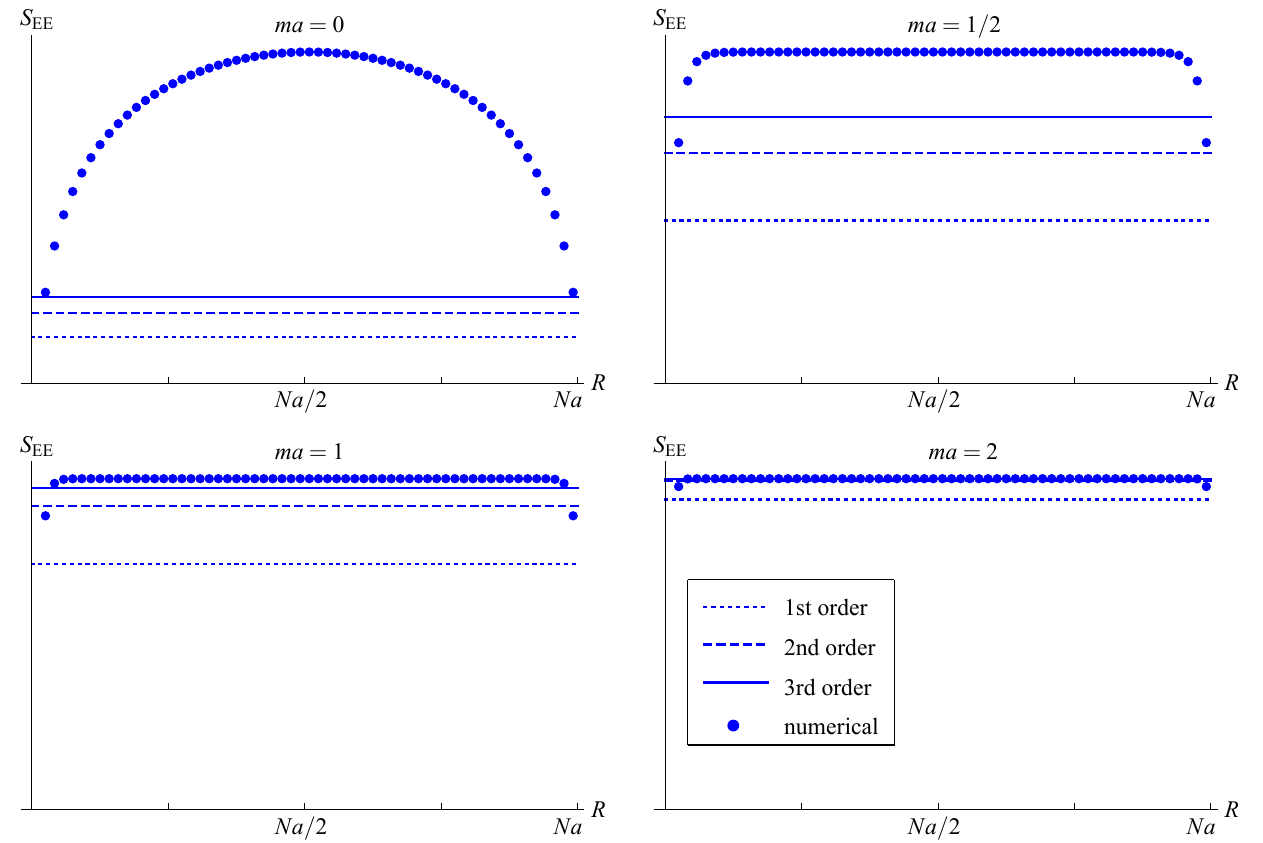
Fig. 3 Comparison of the numerical results for entanglement entropy to the first, second and third order inverse mass expansion. The vertical axes do not have the same scale, entanglement entropy is a decreasing function of the mass parameter, as in higher